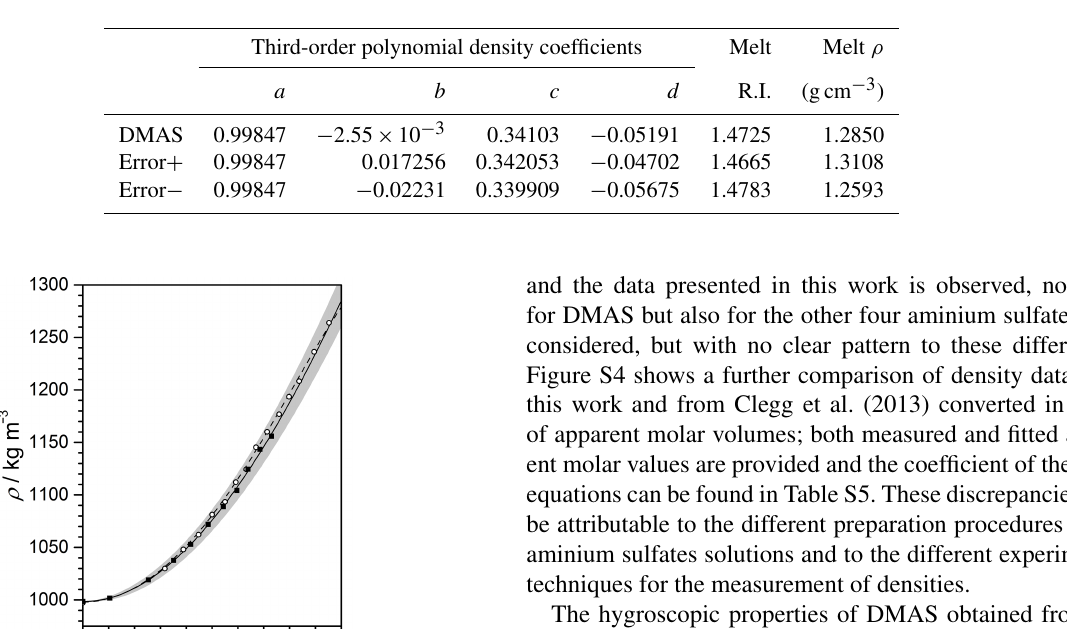
Table 1. Parameters of the third-order polynomial parameterisation for density and refractive index (R.I.) of the melt calculated with molar refraction mixing rule (Sect. 2.1). DMAS is the original fitting of experimental data (black circles in Fig. 9), while “Error + ” and “Error − ” are calculated supposing a ± 2% error on the extrapolated ρ melt , as described in the text.